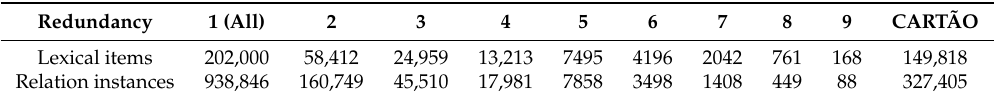
Table 8. Size of the redundancy-based LKBs.